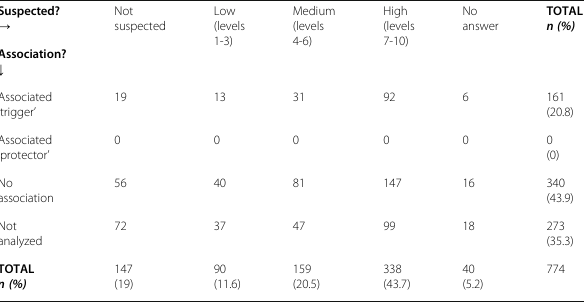
Table 1 (abstract S27). See text for